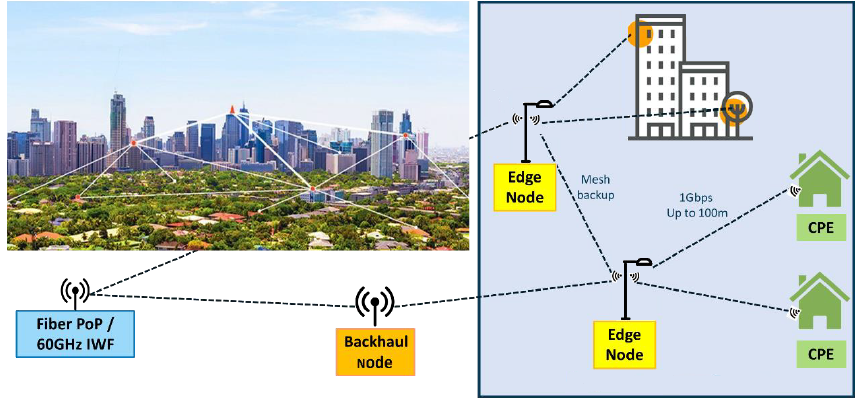
Figure 1. Fixed wireless access network topology in the 60 GHz Band. (PoP = point-of-presence, IWF = inter-working function, CPE = customer premises equipment)